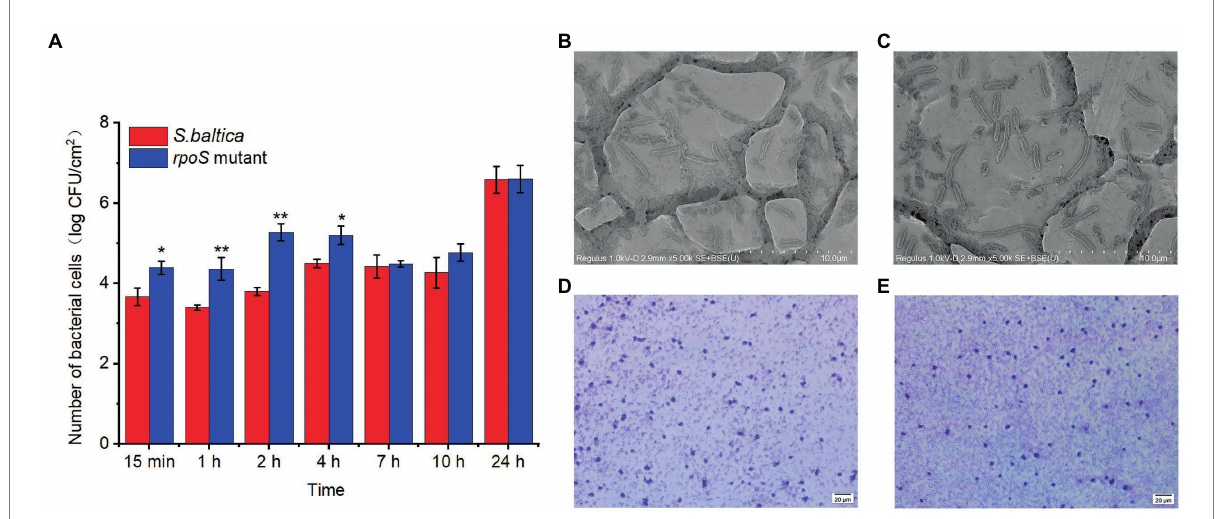
FIGURE 2 Number of bacterial count on stainless steel coupon, “*” and “**” indicate the significant difference at p < 0.05 and p < 0.01, respectively (A) . Scanning electron microscopy images of biofilm formed on stainless steel coupon by Shewanella baltica (B) , and rpoS mutant (C) . Microscopic visualization of biofilm formed on glass slide by S. baltica (D) , and rpoS mutant (E)